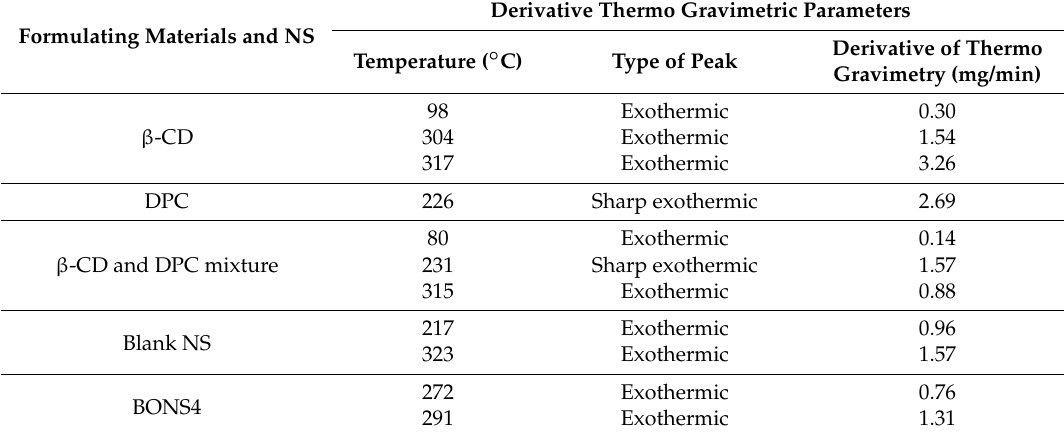
Table 3. Derivative thermogravimetric analysis of the fabricating materials and nanosponges.